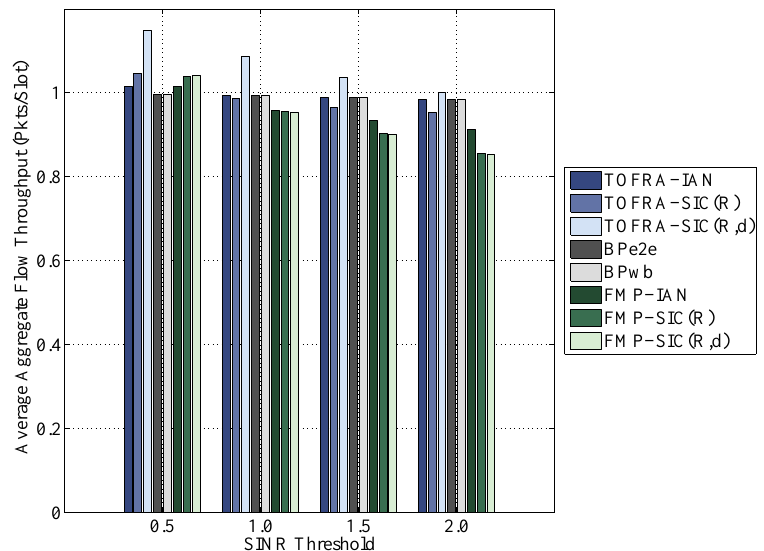
Figure 5. Topology 3: AAT per flow allocation